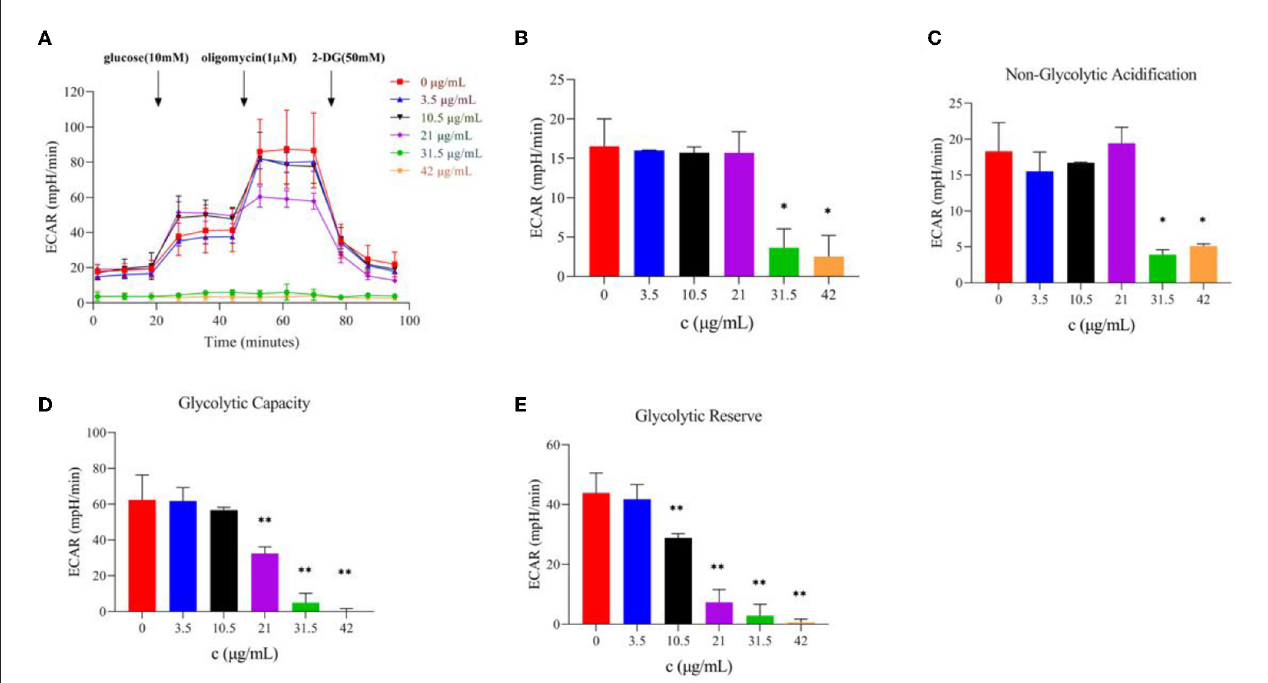
FIGURE6 Effect of TG on the glycolytic function of HepG2 cells. (A) Curves of ECAR values at different times. (B) ECAR histogram of TG with different concentrations. (C) Non-glycolytic acidification with different TG concentrations. (D) The glycolytic capacity of TG at different TG concentrations. (E) Glycolytic reserve with different TG concentrations. * P < 0.05; ** P < 0.01.